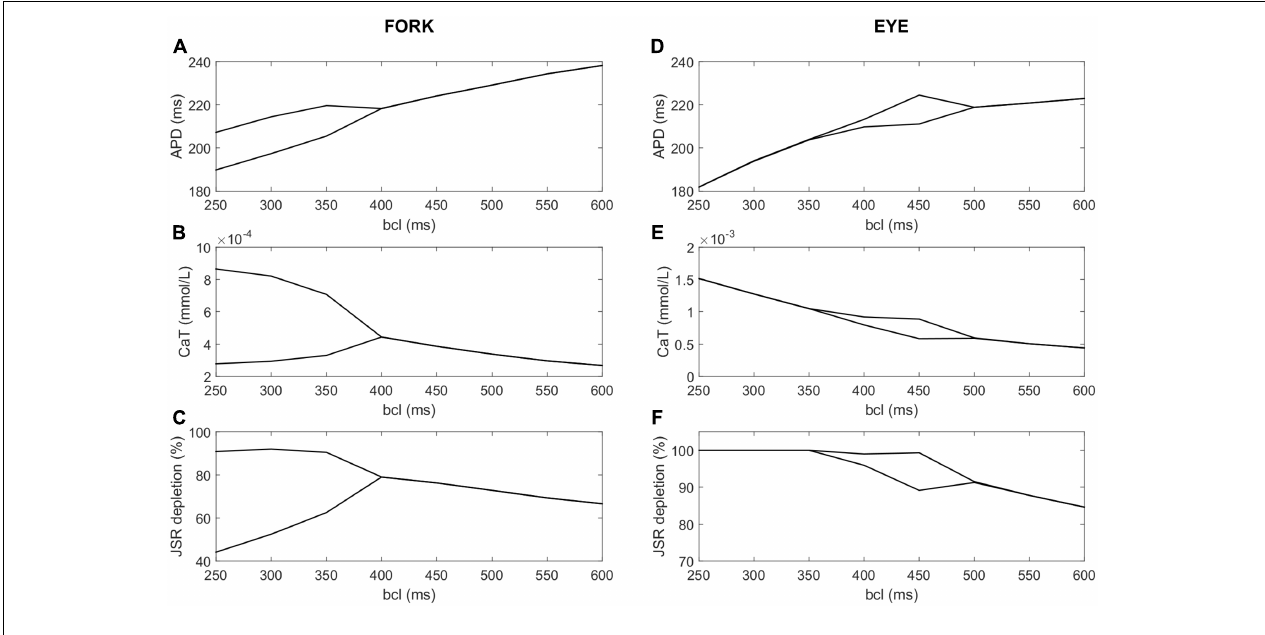
FIGURE 10 | A comparison of fork and eye-type alternans in the ORd model. The left column shows fork alternans in APD (A) and calcium transient amplitude (B) , with underlying fractional JSR depletion per action potential (C) , computed as: 100 ∗ action potential and Ca JSR , start is the starting JSR calcium concentration in the same action potential. In panels (D–F) are respectively shown APD, CaT, and depletion in eye-type alternans. All plots show the values of the two last action potentials for every bcl and variable of interest; bifurcation indicates that the last two action potentials differ in the variable of interest, manifesting